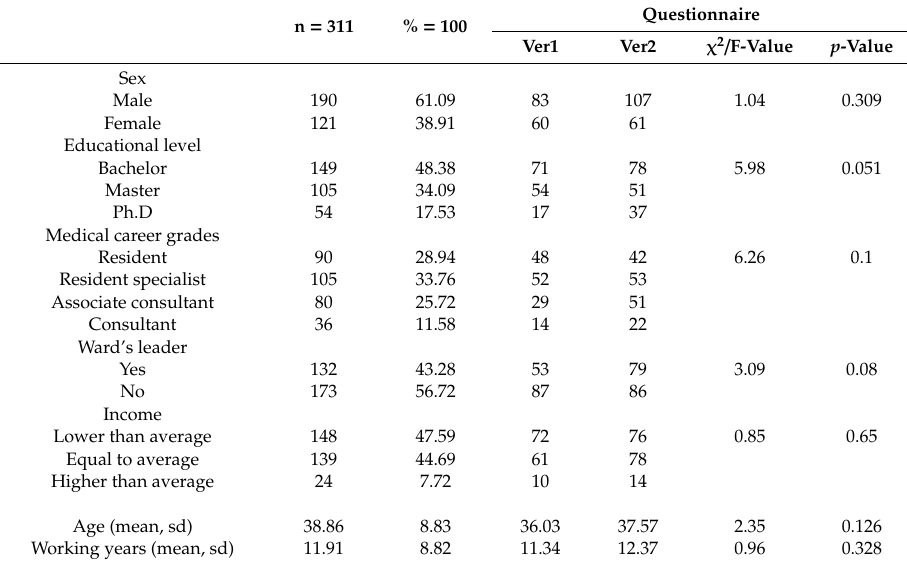
Table 3. The background information of